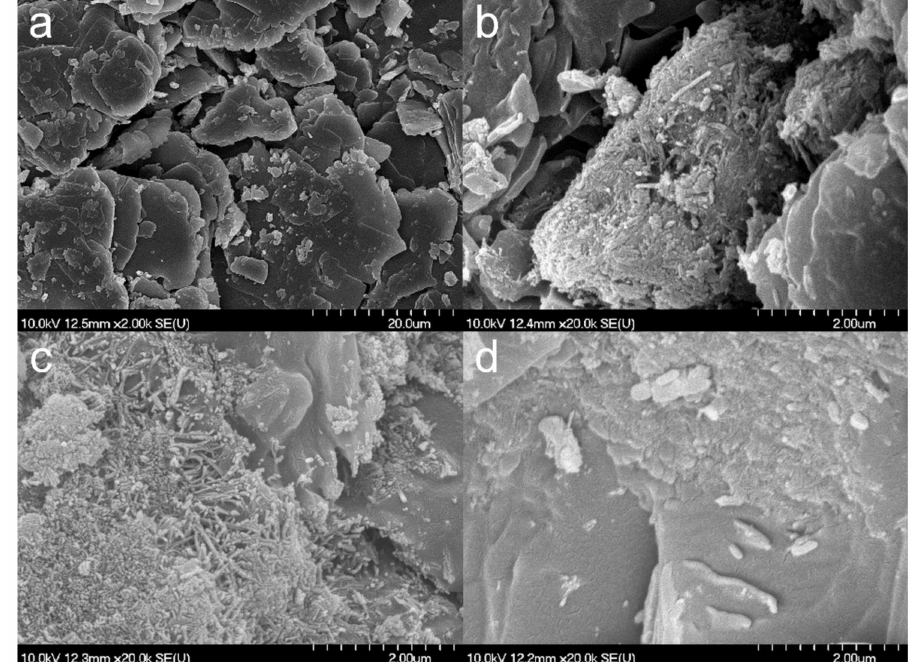
Figure 3. SEM micrographs of atenolol ( a ), TiATN–ethanol ( b ), TiATN–methanol ( c ), and TiATN–HCl 0.01 M ( d